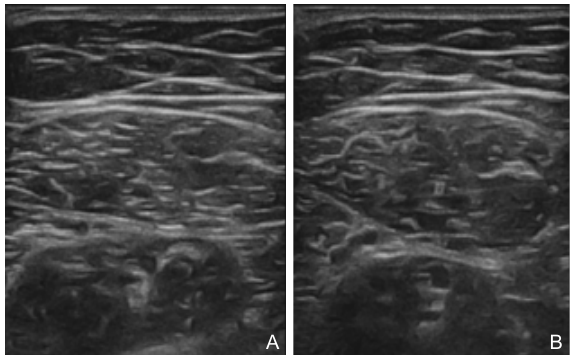
Figure 2 Ultrasound image of the rectus femoris muscle in different states. (A) Resting state; (B) Tense state.